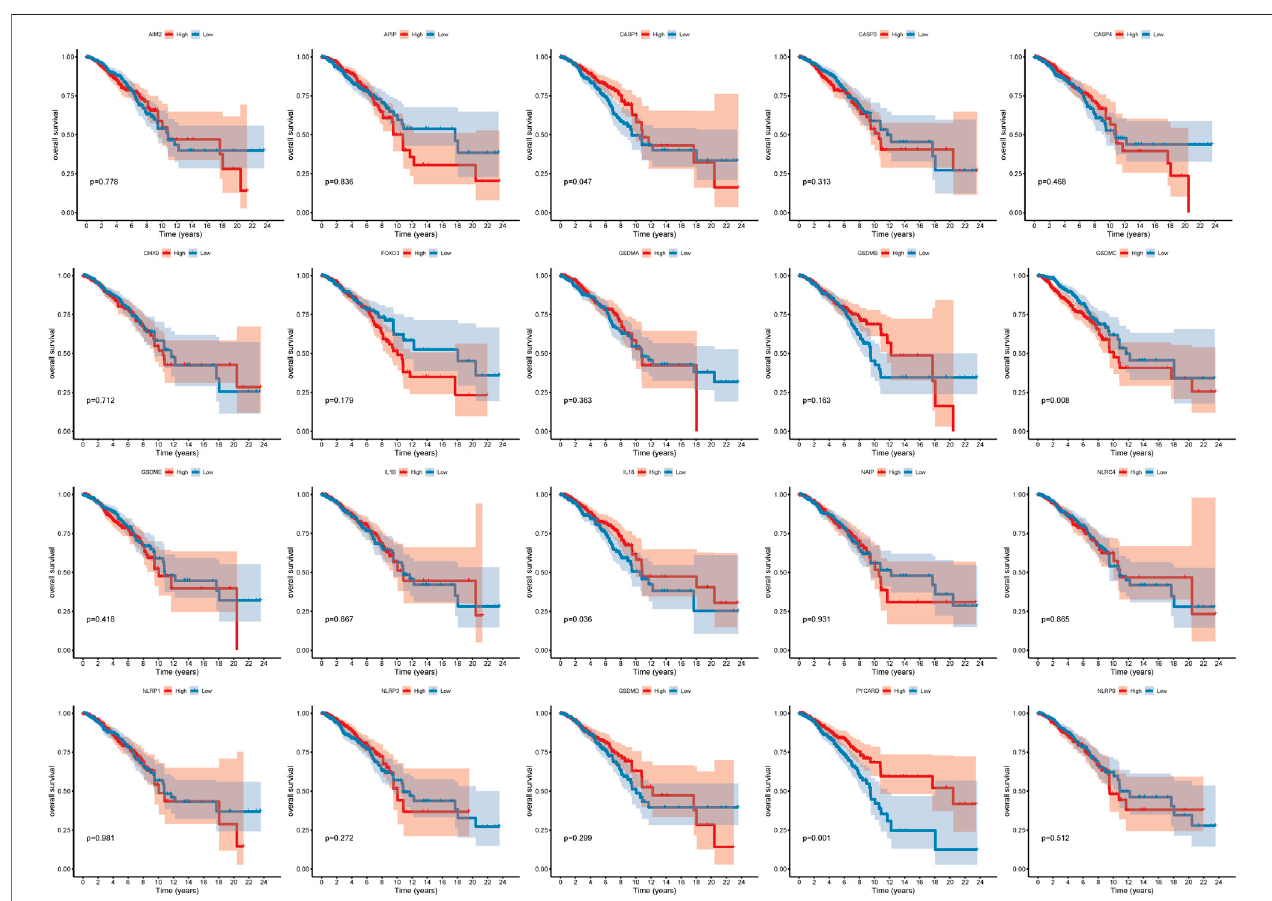
FIGURE 1 | Survival curve of pyroptosis-related genes.